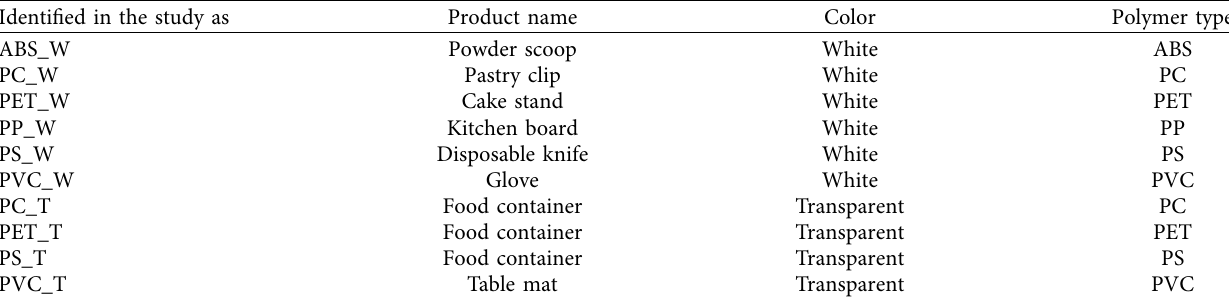
Table 2: Description of the commercially available plastic